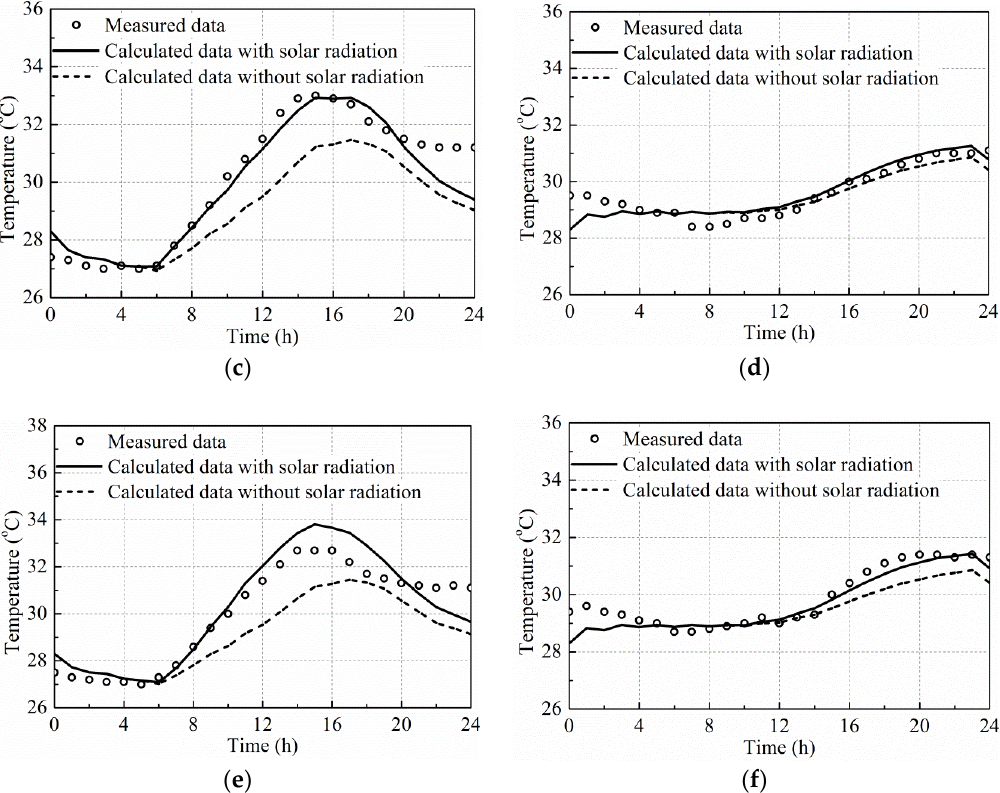
Figure 11. Influence of solar radiation on temperature distribution on cross-section of box girder in summer (2 August 2010): ( a ) east web (EW-1); ( b ) east web (EW-2); ( c ) west web (WW-1); ( d ) west web (WW-2); ( e ) bottom flange (B-1); and ( f ) bottom flange (B-2).